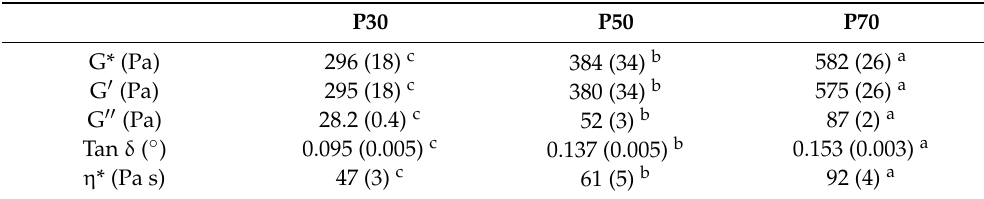
Table 5. Rheological parameters (G*, complex modulus; G (cid:48) , storage modulus; G (cid:48)(cid:48) , loss